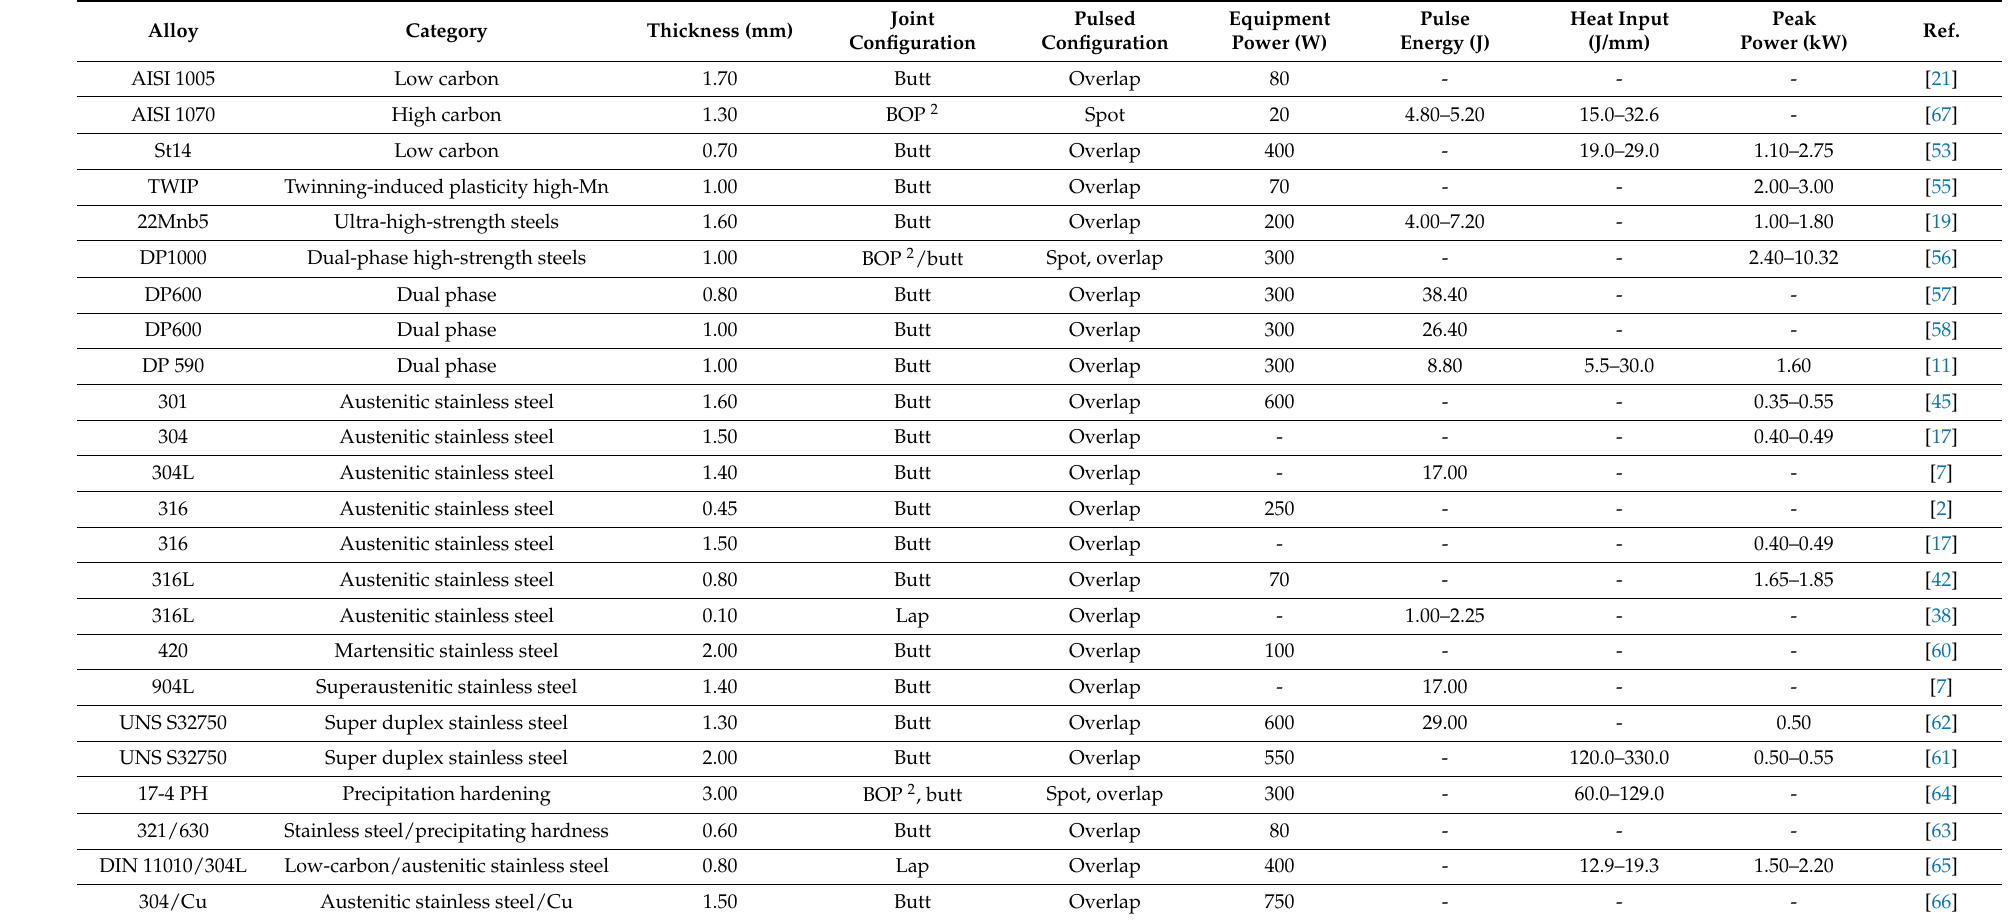
Table 2. Details of pulsed laser welding conditions applied to steel 1